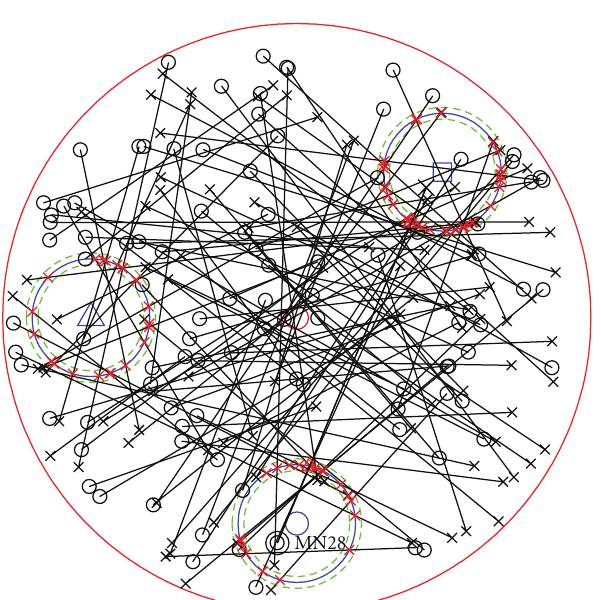
Figure 9: Determining no. of HOs by geometric calculation.